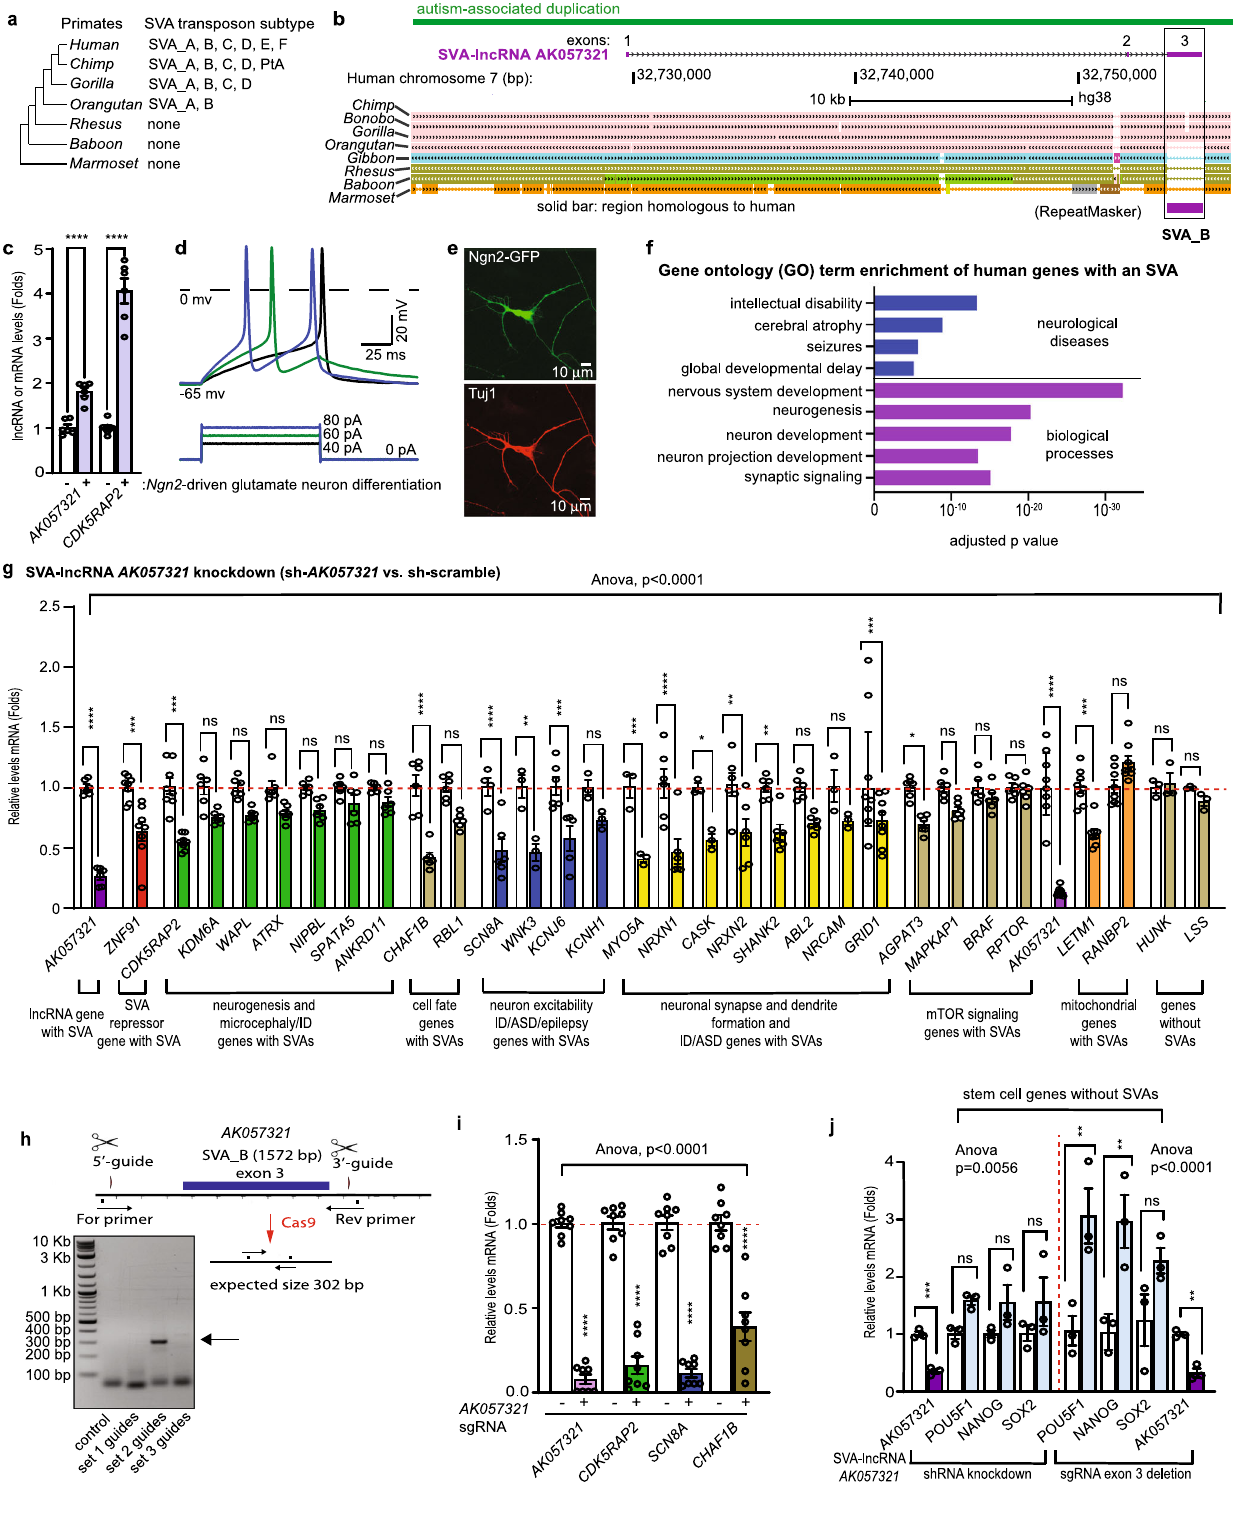
SVAs to repress gene expression . Based on our observations that SVA-lncRNA AK057321 increases during neuronal maturation (Fig. 1c, Supplementary Fig. 3) and increases expression of neu- ronal genes with intronic SVAs such as the microcephaly gene CDK5RAP2 (Fig. 1c, g – i), we reasoned SVA-lncRNA AK057321 might function to initiate neuronal maturation by relieving the repression of genes by their intronic SVAs. For a second inde- pendent test of the potential role of SVAs in human neuronal